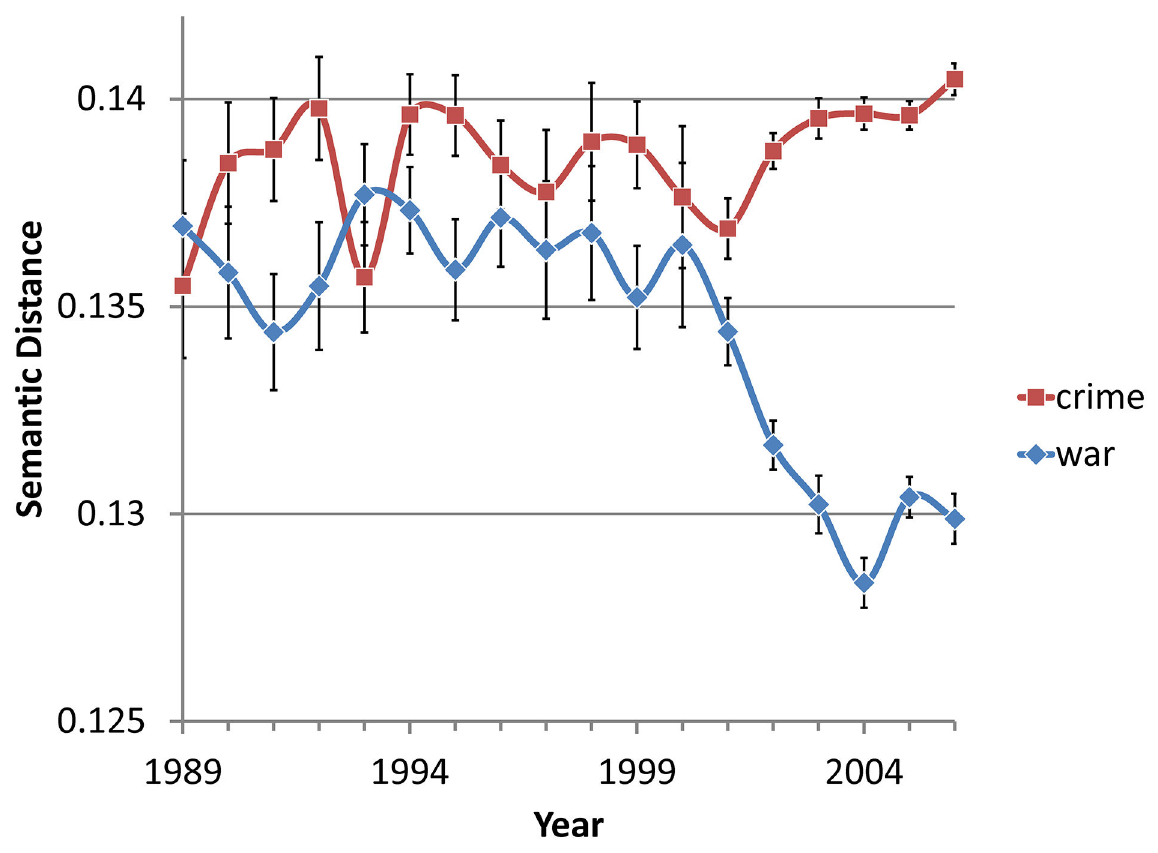
Figure 3. Mean context vector distances of war and crime from terror by year. As the zero point of the graph represents identical uses for the term in question and terror, lower positions in the graph represent greater relevance for the term as a frame of terror . Error bars represent standard